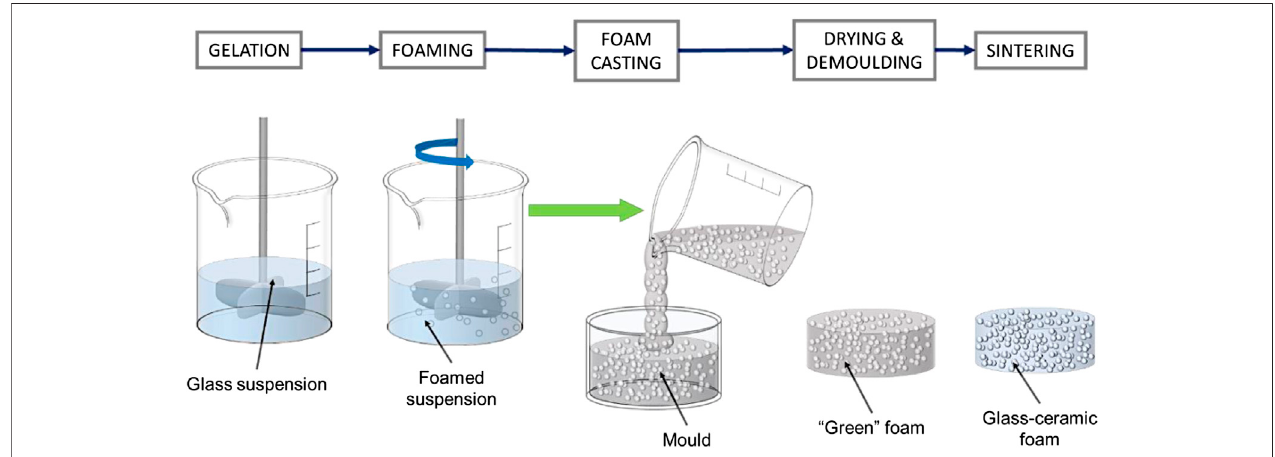
FIGURE 1 | Schematic view of “ foam casting ”